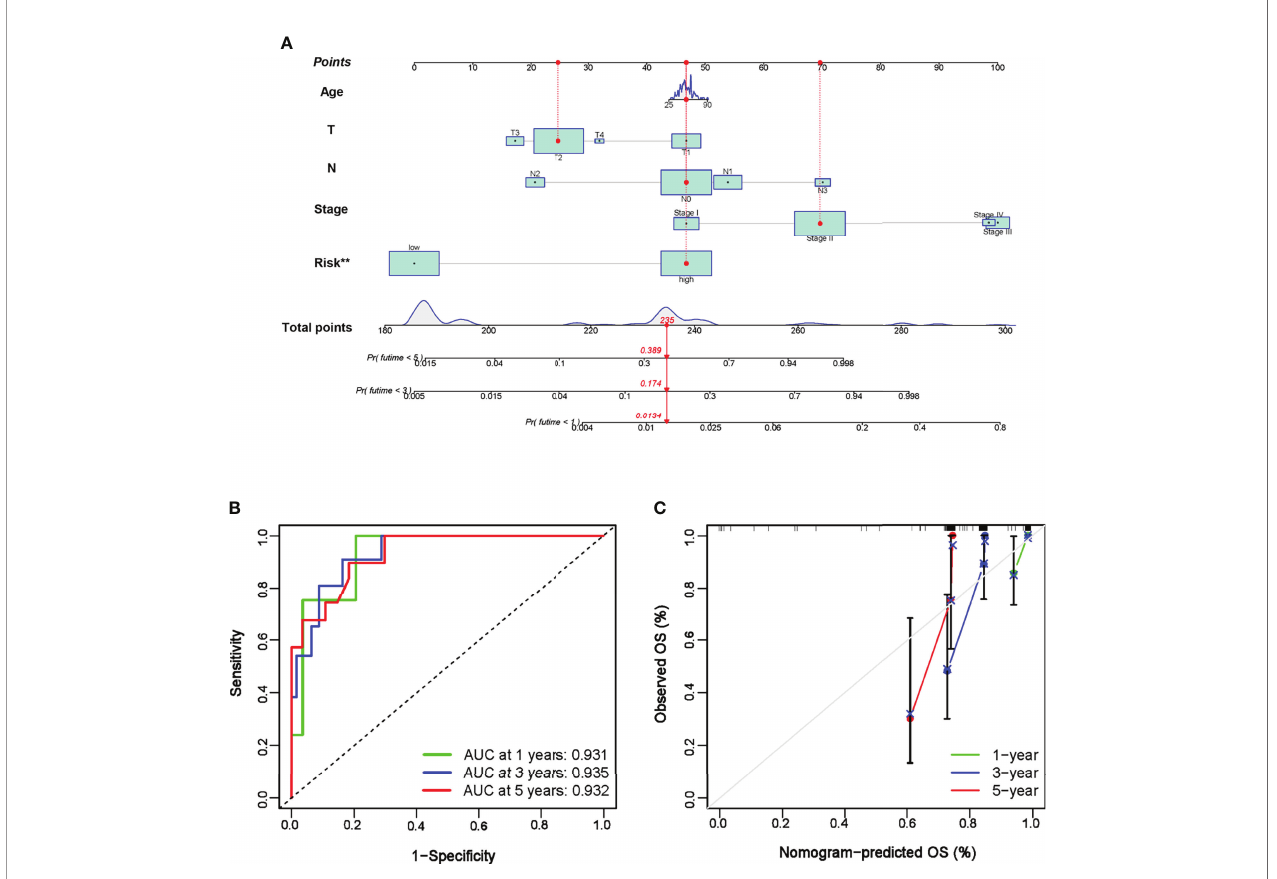
FIGURE 5 | Establishment of nomogram prediction. (A) A nomogram was constructed to calculate the OS at 1, 3, and 5 years in TNBC patients. (B) Time- dependent ROC curve of the nomogram in 1-, 3-, and 5-year OS. (C) Calibration curves of the established nomogram. ** P <